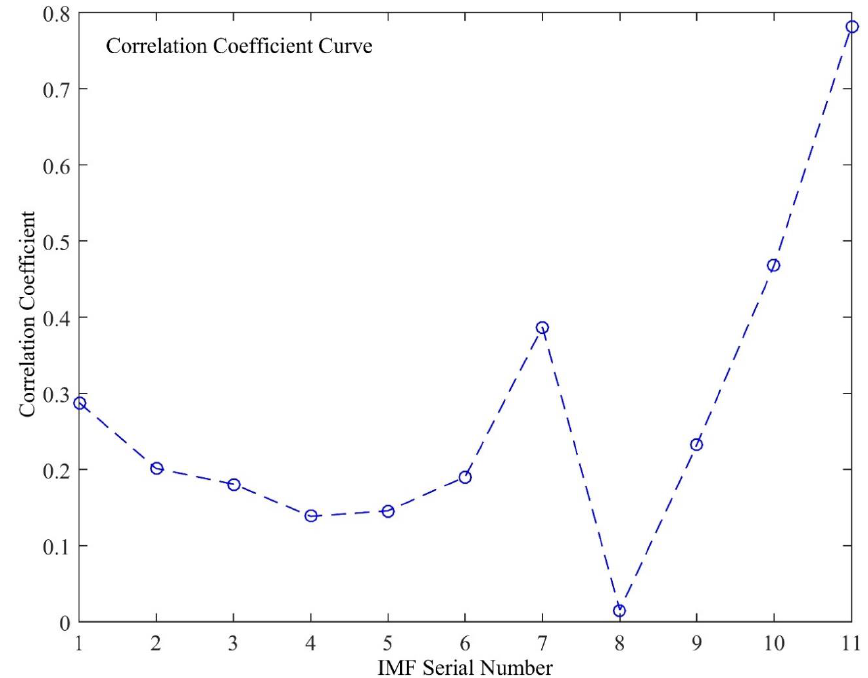
Figure 15. The correlation coefficient between the 𝐼𝑀𝐹 obtained by empirical mode decomposition (EMD) and the original signal.